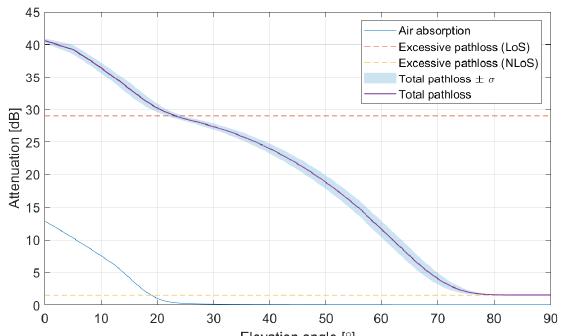
Figure 4. Different types of attenuation and the mean of total attenuation (purple line) with changing elevation angle θ e . As the PLoS depends on the elevation angle, as shown in (8). IoT devices will suffer mostly NLoS condition when θ e < 10 ◦